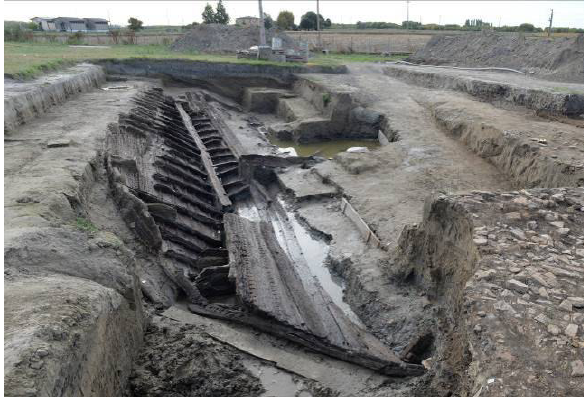
Figure 2. Archaeological site at the end of the excavation in 2015.